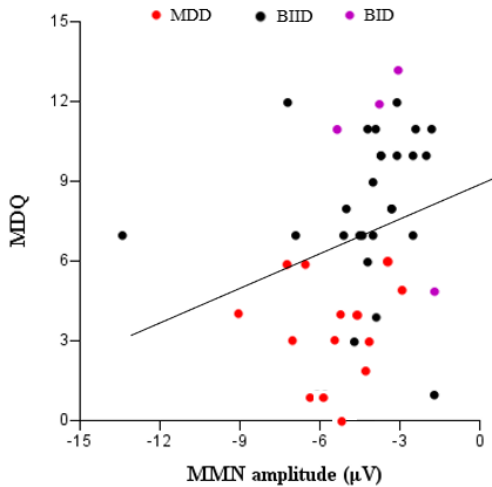
Figure 1. Correlation between K-MDQ (Korean version of the Mood Disorder Questionnaire) and the MMN (mismatch negativity) amplitude (F4) ( r = −0.37, p = 0.014).